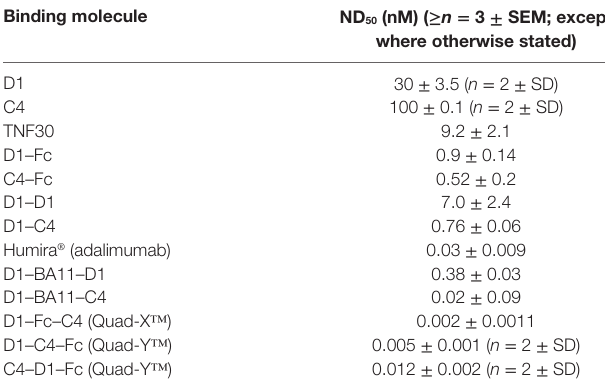
TaBle 2 | Neutralization of 0.3 ng/ml (LD 80 ) hTNF- α -induced cytotoxicity in L929 cells. Binding molecule